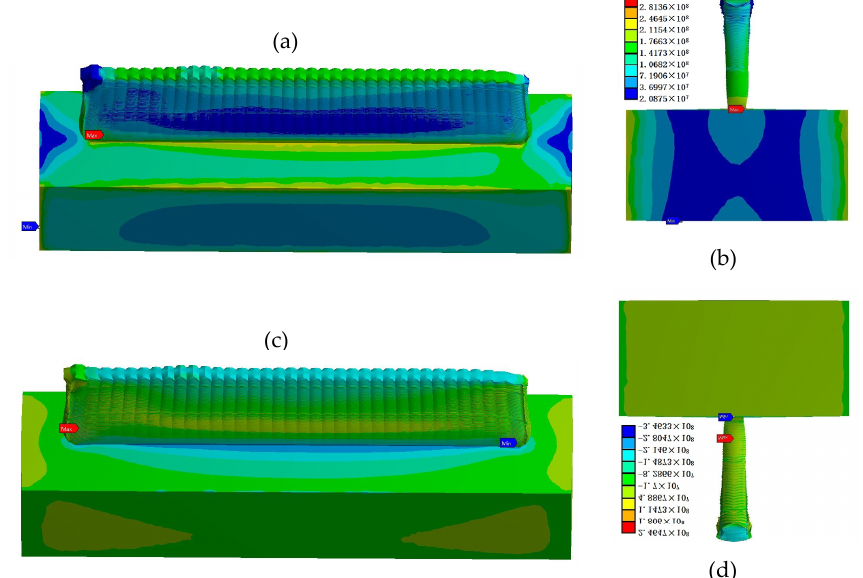
Figure 16. Finite element analysis results of stress field of thin-walled parts at the end of AM (amplification: 17 × ): ( a , b ) Von Mises stress distribution; ( c , d ) normal stress distribution.